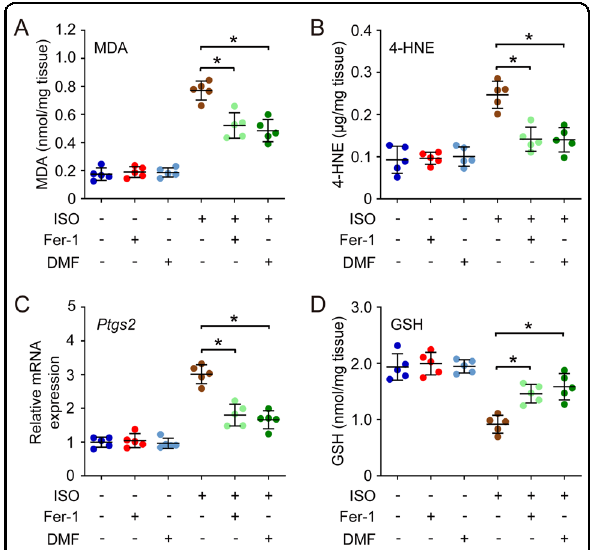
Fig. 4 Pre-treatment with Fer-1 and DMF rescue iso fl urane- induced ferroptosis. In the pre-treatment, 15 mg/kg DMF was administered (i.p.) 16 h before anesthesia, and 1 pmol of Fer-1 was injected into the striatum immediately before anesthesia. Then, the mice received iso fl urane exposure (ISO, 1.5%) for 6 h, and the hippocampus was isolated for the analysis. Herein, the level of MDA ( A ) and 4-HNE ( B ), the expression of Ptgs2 ( C ), as well as the level of GSH ( D ), were measured to evaluate the ferroptosis in each group. * p value < 0.05 compared between two groups.